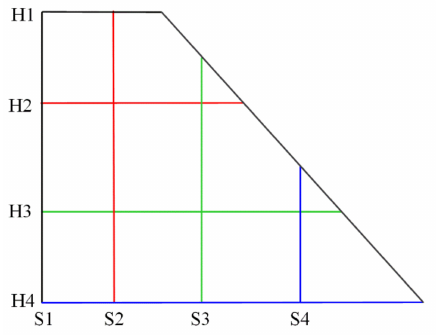
Figure 9. Ash variation curves of transverse and